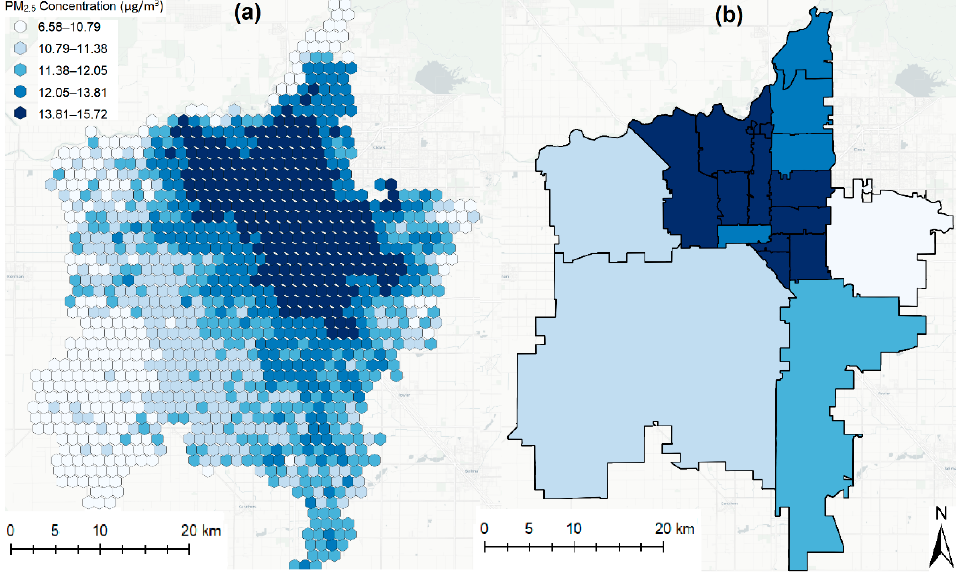
Figure 2. Example of PM 2.5 concentration (µg/m 3 ) gradients at ( a ) 1 km 2 and ( b ) ZIP Code-based spatial resolutions (Fresno, CA).